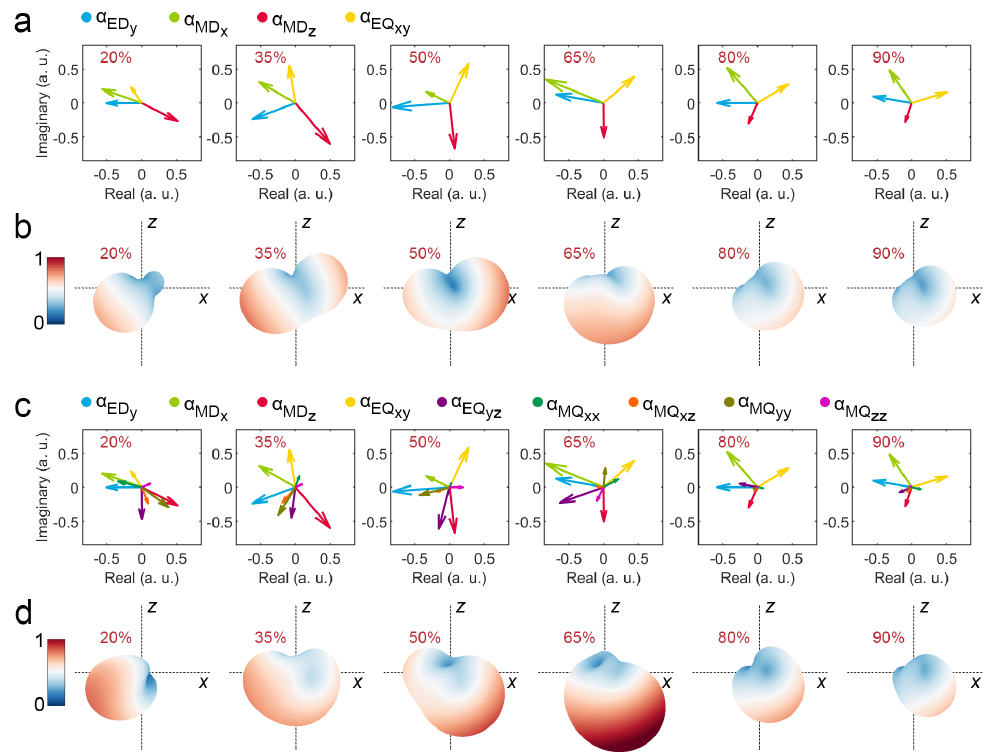
Figure 7. Interference far-field radiation patterns reconstructed by calculated complex multipole scattering coefficients in crystallinities of 20%, 35%, 50%, 65%, 80%, and 90%: ( a ) Modulus normalized complex multipole coefficients and ( b ) corresponding reconstructed far-field radiation of moments with major contribution to D directivity; ( c ) Modulus normalized complex multipole coefficients and ( d ) corresponding reconstructed far-field radiation of all non-zero moments.